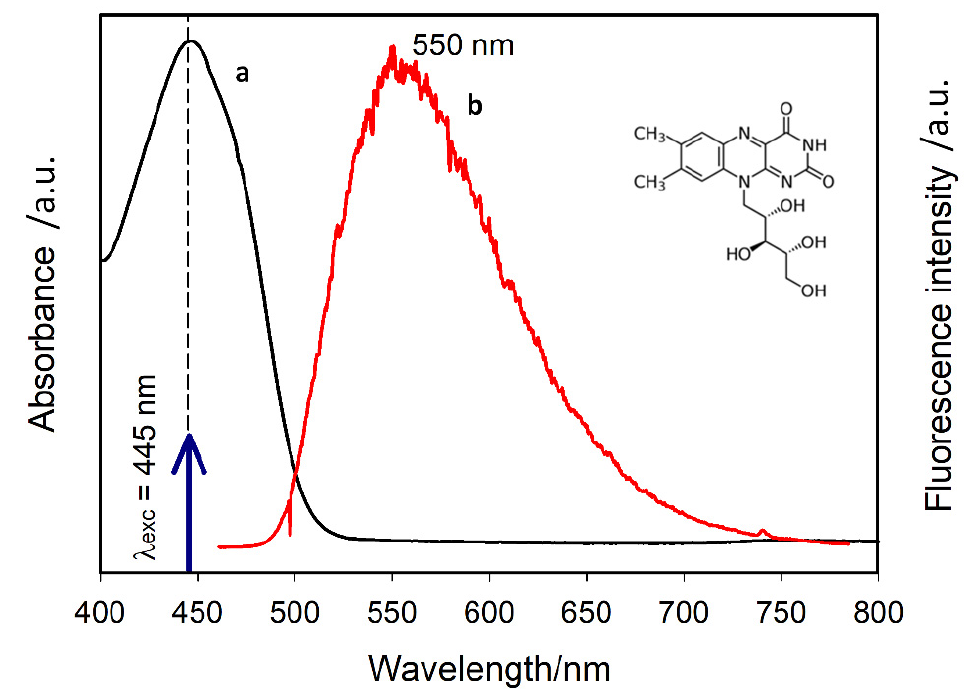
Figure 1. Absorption ( a ) and fluorescence ( b ) spectrum of riboflavin solution in water. The vertical arrow indicates the excitation wavelength. The chemical formula of riboflavin is shown as an inset.